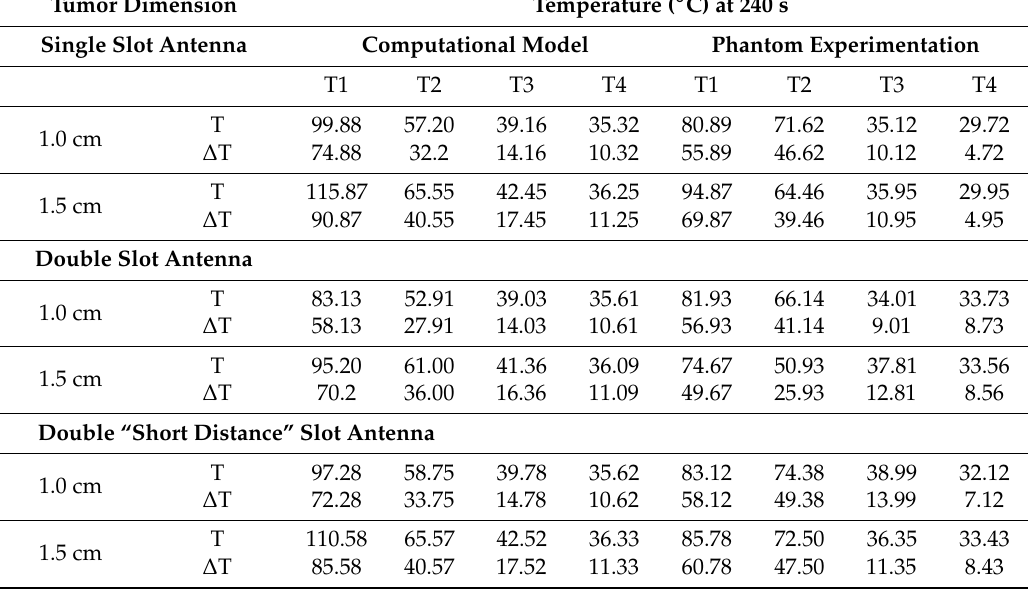
Table 3. Maximum temperature in thermal sensors alongside the antenna for single, double and double “short distance” slot antennas in tumor phantom surrounded by breast tissue: computational model and phantom experimentation results (T1, T2, T3, and T4 were the thermal sensors placed at 0.0, 0.5, 1.0 and 1.5 cm from the antenna slot, respectively). Tumor Dimension Temperature ( ◦ C) at 240 s Single Slot Antenna Computational Model Phantom Experimentation